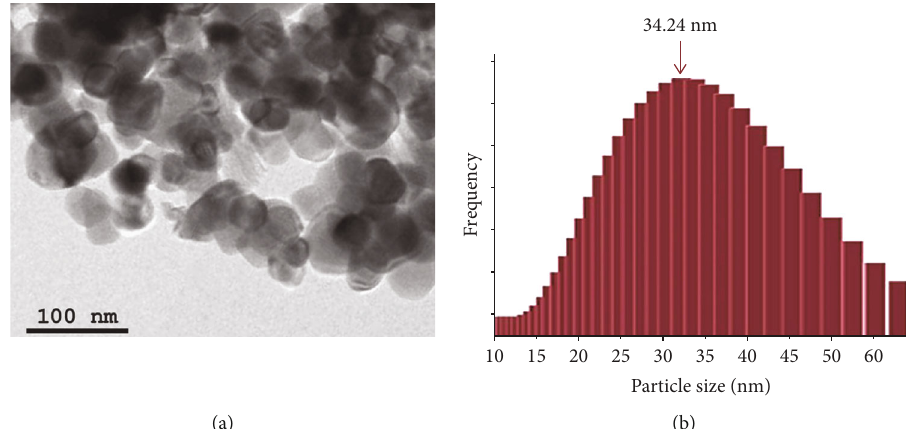
Figure 1: Phytosynthesized TiO nanoparticles, indicating their morphological features using TEM (a) and particle size distribution 2